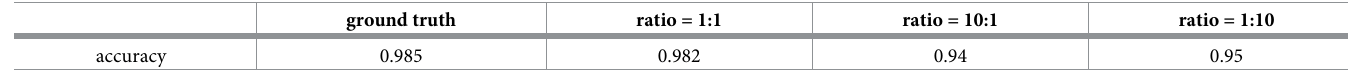
Table 4. Prediction accuracy of different imbalanced initializations ratio (class 1: Class 0) on the testing set and ground-truth boundary. ground